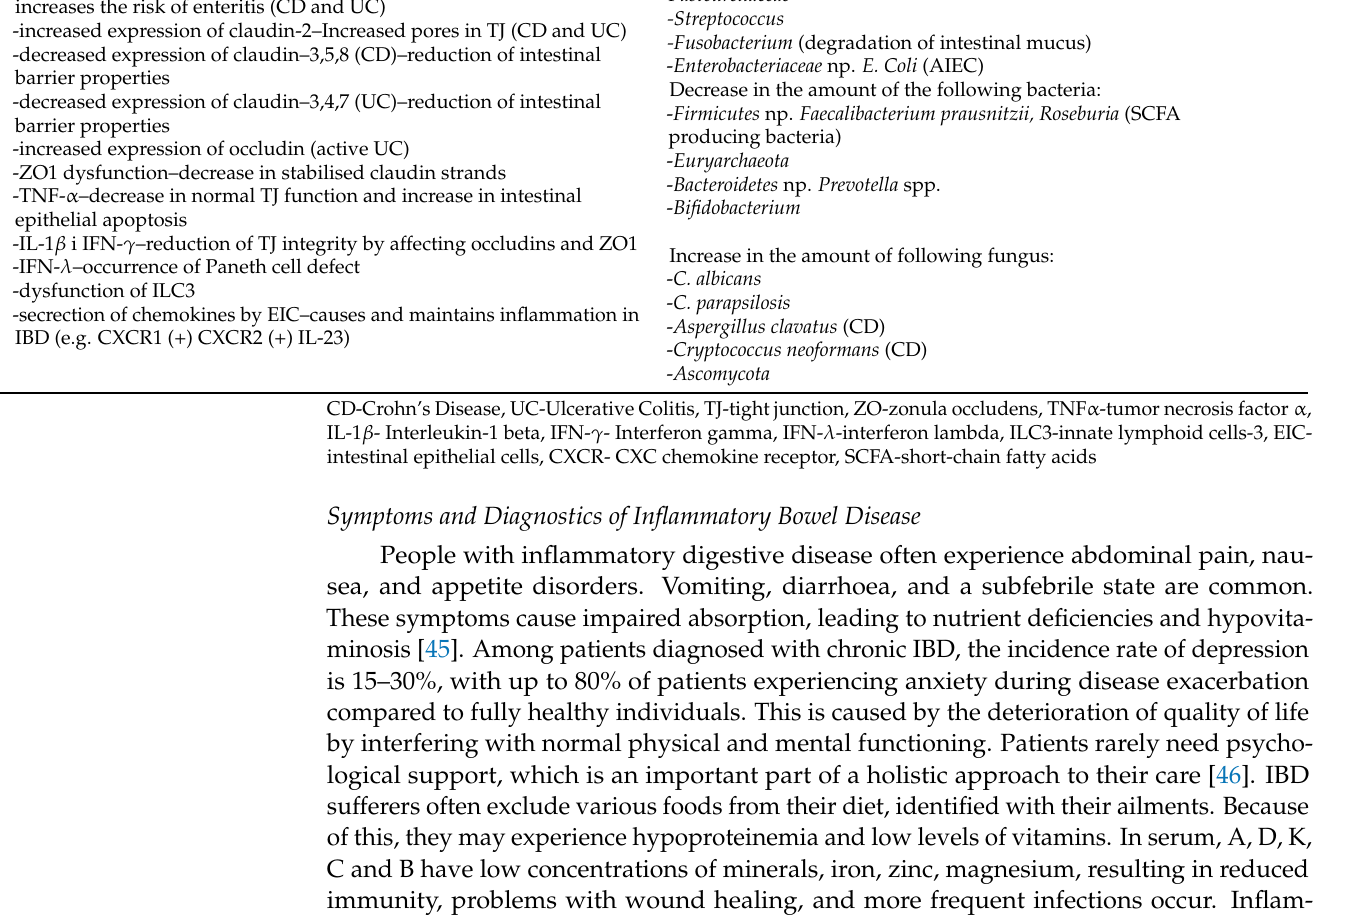
Table 1. Intestinal homeostasis disturbances in patients with inflammatory bowel disease [34–44] .